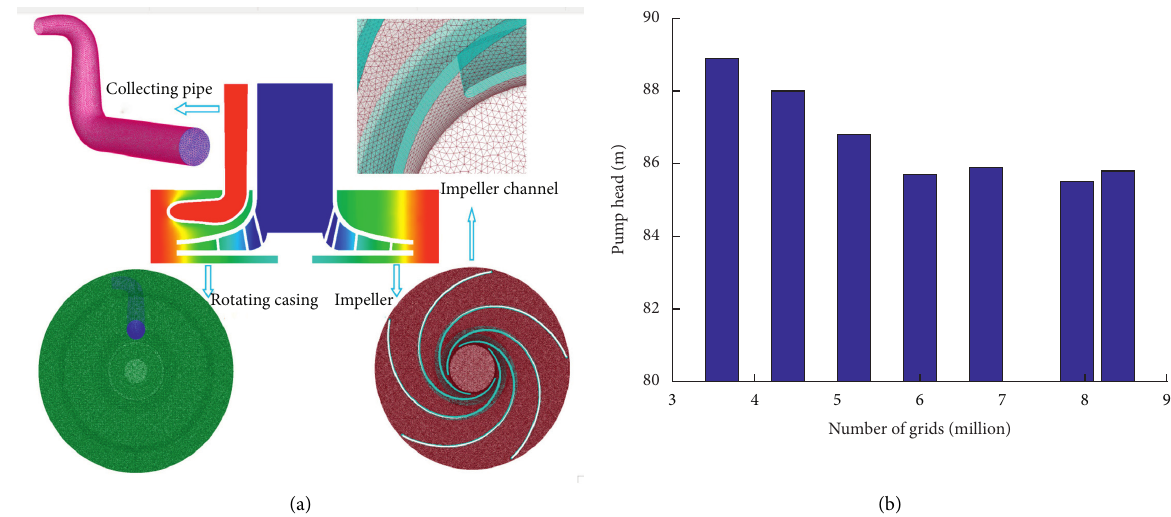
Figure 2: Grids of Roto-Jet pump and grid independence verification. (a) Grids of Roto-Jet pump. (b) Grid independence